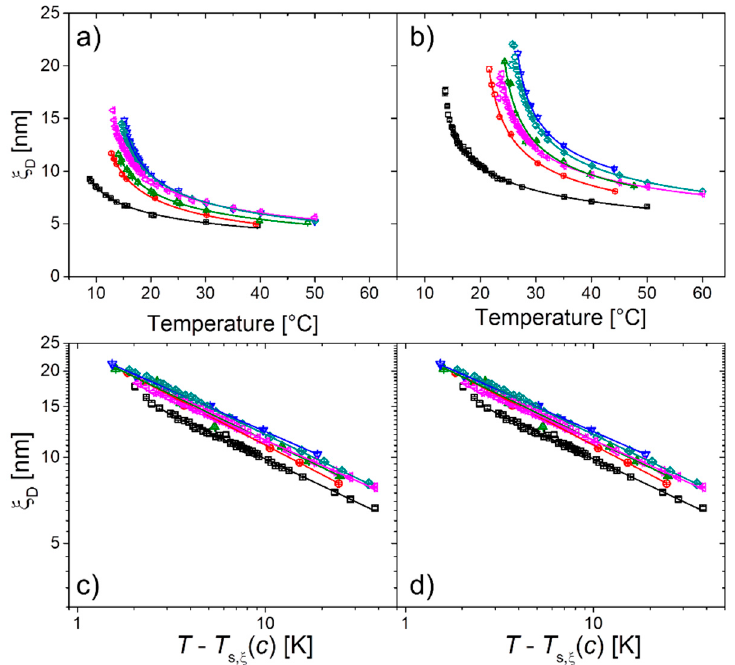
Figure 5. ( a , b ) Dynamic correlation lengths, ξ D , as function of temperature. The T -range of the lines corresponds to the data points used for the fits. ( c , d ) Same intensity data in dependence on reduced temperature, τ , in log-log representation. Symbols: experimental data as in Figure 3, lines: fits of Equation (2) ( a , c ) PSPP 85 , ( b , d ) PSPP 280 .